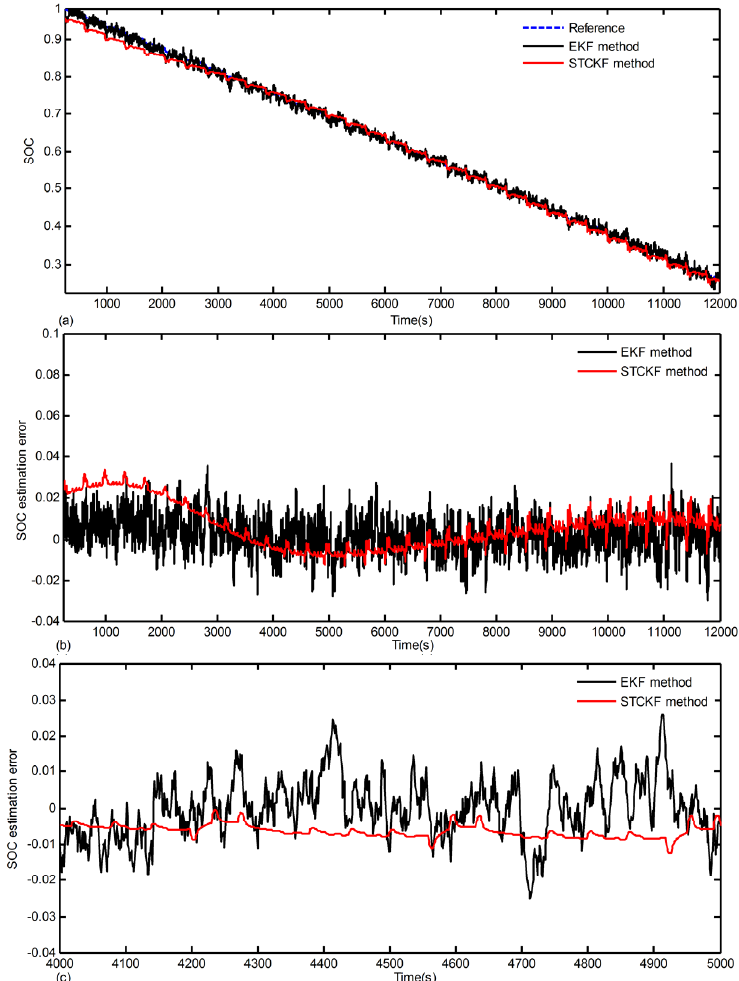
Figure 6. The estimation results under Dynamic Stress Test (DST): ( a ) SOC estimation profile; ( b ) SOC estimation error profile; and ( c ) Zoom plot of SOC estimation error profile.